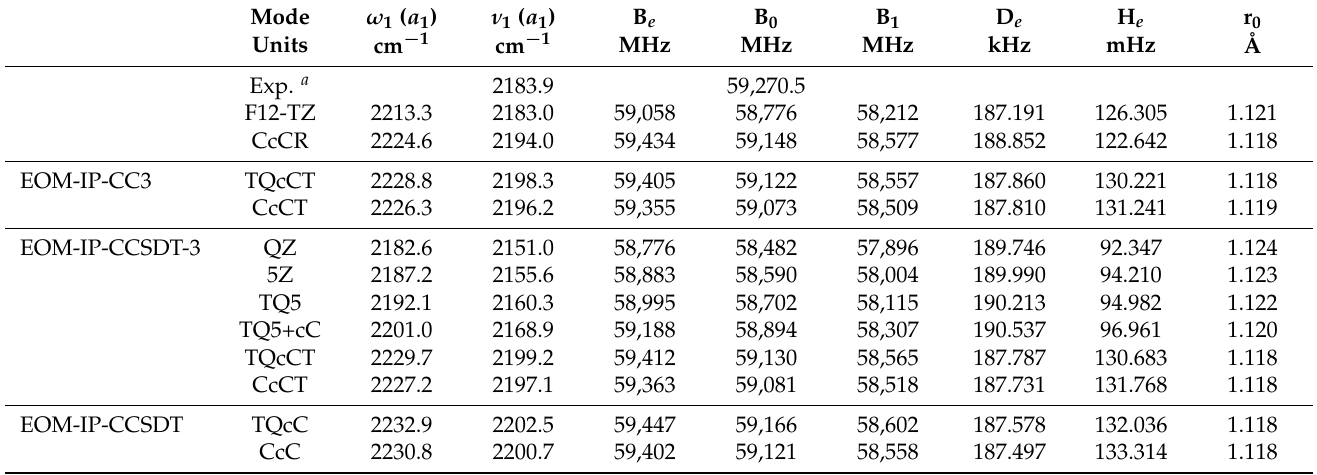
Table 1. ˜X 2 Σ + CO + Vibrational Frequencies, Distortion Constants and Geometrical Parameters.